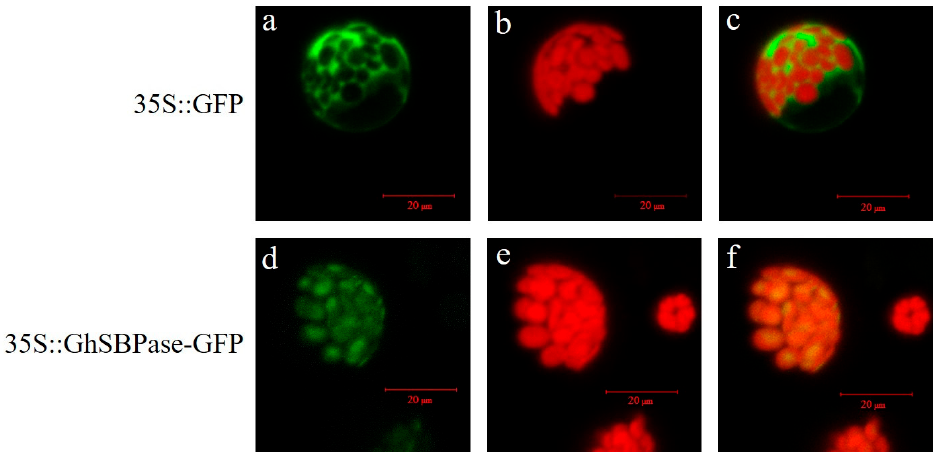
Figure 6. Subcellular localization of GhSBPase protein in upland cotton. Confocal microscope im- ages of the GFP fluorescence ( a , d ), chlorophyll auto fluorescence ( b , e ), and the merged images for GFP fluorescence and chlorophyll auto fluorescence ( c , f